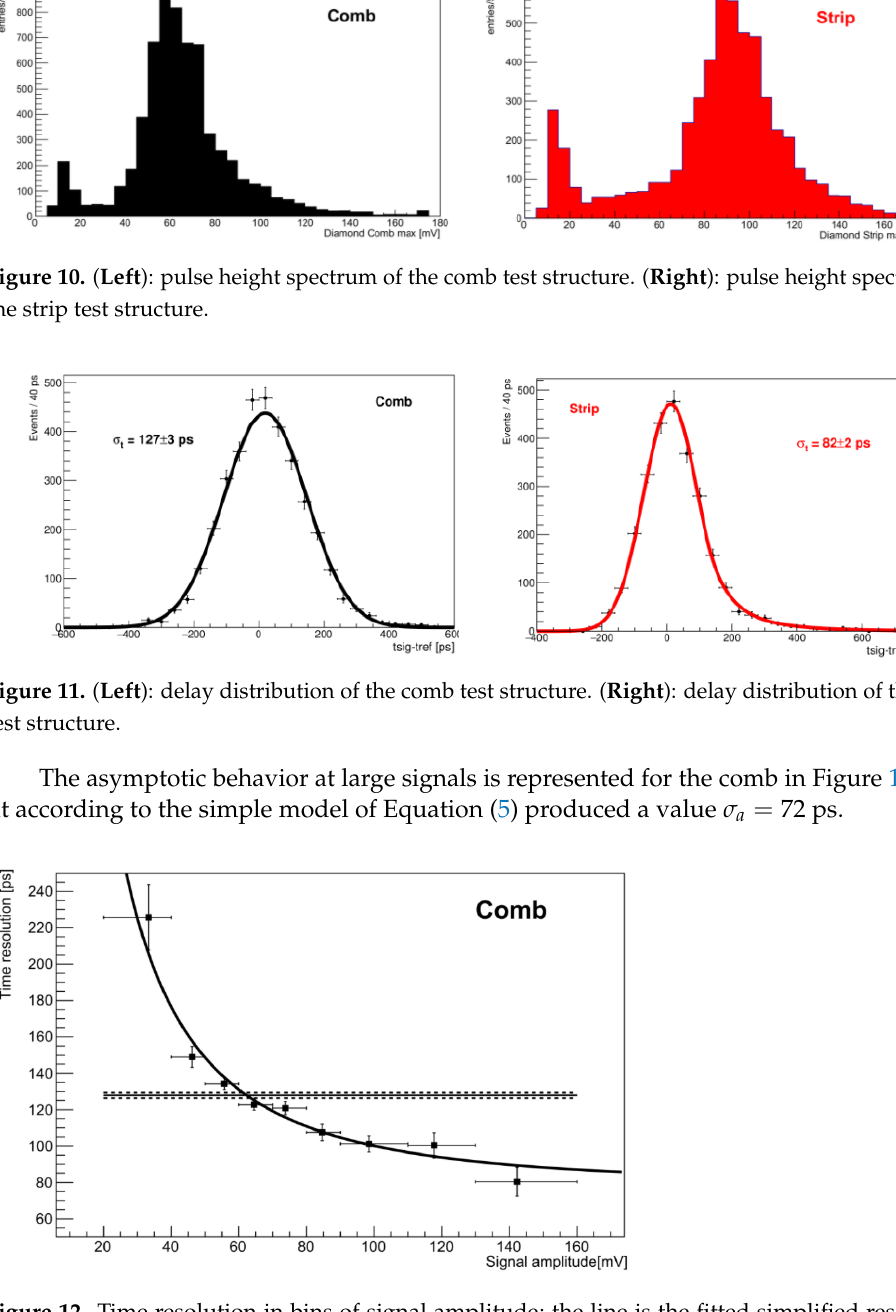
Figure 12. Time resolution in bins of signal amplitude; the line is the fitted simplified resolution model of equation [43]. The horizontal line represents the resolution value resulting from the delay distribution of Figure 11